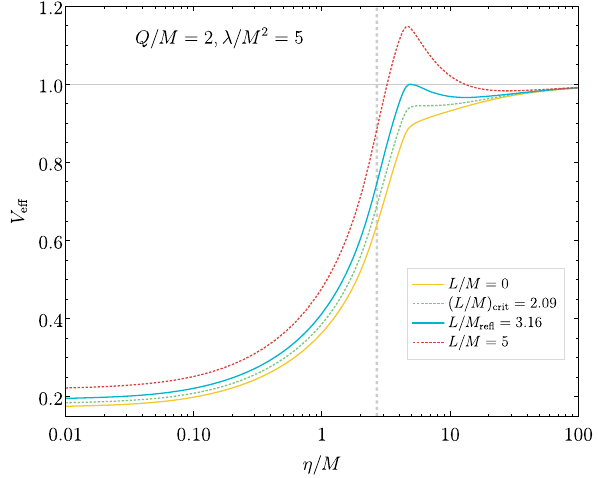
Fig. 31 Same as Fig. 25 for a wormhole with equator (coupling func- tion (iii), parameters Q / M = 2, λ/ M 2 = 5). The dotted vertical line indicates the throat